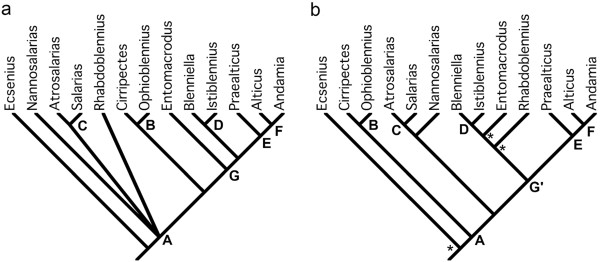
Generic relationships of the blenniid tribe Salariini. (a) Hypothesized relationships based on Smith-Vaniz and Springer [50] and updated in Springer and Williams [51]. (b) Consensus relationships based on Maximum Likelihood, Maximum Parsimony, and Bayesian Inference in this study. *= node not supported by Maximum Parsimony. Nodes labeled with the same letters (A-G) in both (a) and (b) are identical. Node G’ in (b) is different from node G in (a) by including Rhabdoblennius.